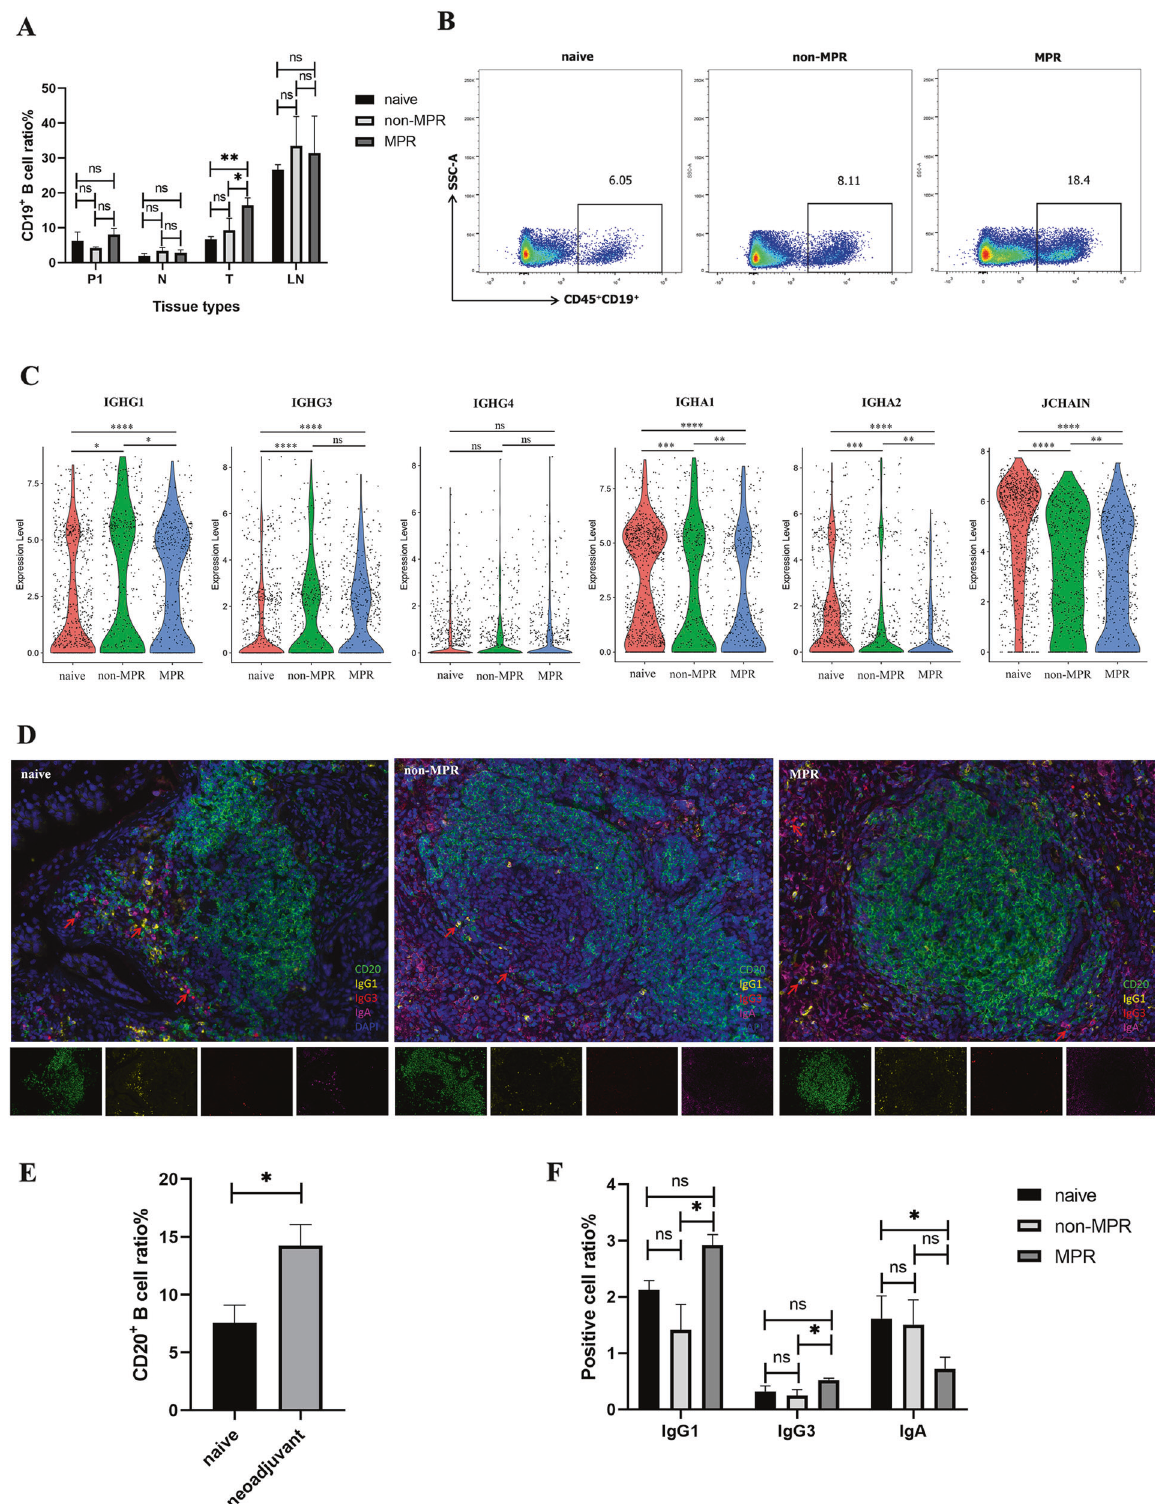
These data indicated the potential for B cell class switching and antibody responses (increased IgG1 and IgG3, diminished IgA) induced by neoadjuvant chemoimmunotherapy to promote favorable anti-tumor immune response.